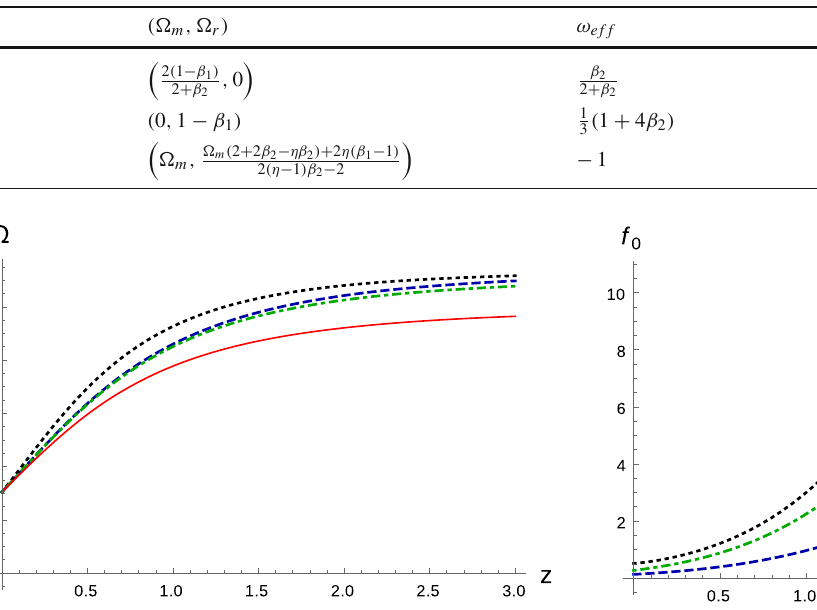
Fig. 1 The Hubble and deceleration parameters as a function of the redshift z for three different values for the constant η = − 0 . 02 (dot- dashed), η = 0 (dashed) and η = 0 . 1 (dotted). We use the best fit values Table 1 The fixed points of the dynamical system (43) and (44) together with eigenvalues and also their behaviors